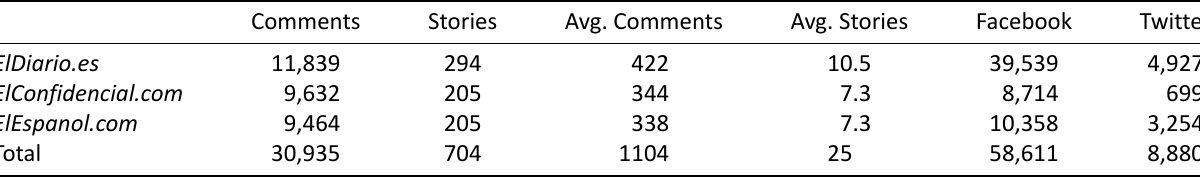
Table 2. Number of comments collected per digital news outlet and social network.